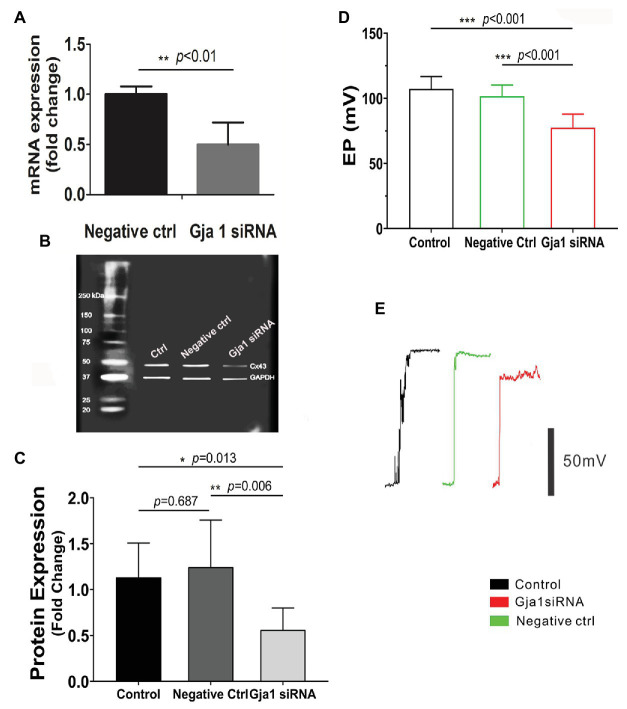
Downregulation of Cx43 reduces endocochlear potential (EP). (A) Real-time PCR analysis shows that Cx43 messanger RNA (mRNA) expression is significantly decreased in the stria vascularis of Gja1 small interfering RNA (siRNA) treated groups [nnegative ctrl = 6, nGja1 siRNA = 6, t(6.186) = 5.327, **p(negative ctrl vs. Gja1 siRNA) < 0.01, Student’s t-test]. (B,C) Western blot analysis shows that Cx43 protein expression is significantly reduced in the Gja1 siRNA treated group [n = 7, F(2,18) = 5.859, *p = 0.011, p(ctrl vs. negative ctrl) = 0.687, *p(ctrl vs. Gja1 siRNA) = 0.013, **p(negative ctrl vs. Gja1 siRNA) = 0.006, one-way ANOVA]. (D) Average EP in the control, control scramled siRNA treated, and Gja1 siRNA treated group. A slight but significant decrease in Cx43 protein expression is seen in the Gja1 siRNA treated group, compared to the normal and control groups [n = 6, F(2,21) = 22.045, ***p < 0.001, one-way ANOVA, ***p(ctrl vs. Gja1 siRNA) < 0.001, ***p(negative ctrl vs. Gja1 siRNA) < 0.001, mean ± SD]. (E) Representative EP waveform in the control, control siRNA treated, and Gja1 siRNA treated group.